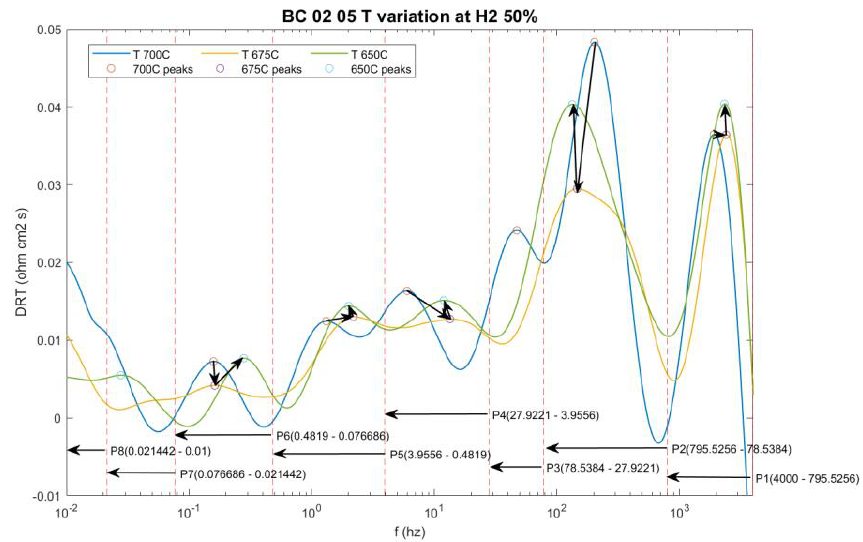
Figure 8. The tool user interface illustrating temperature variation analysis.